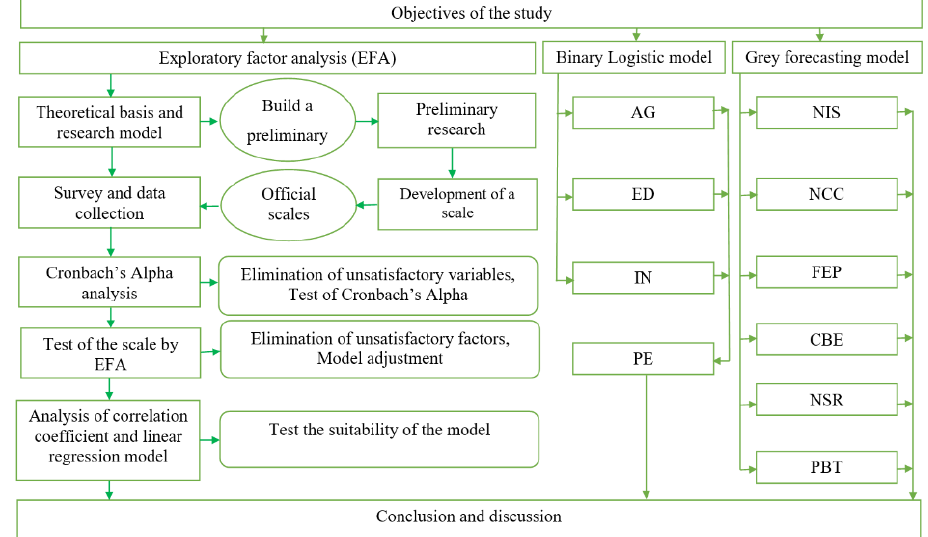
Figure 2. Research process.